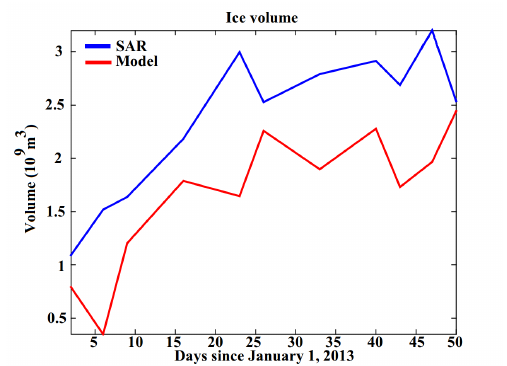
Figure 21. Sea ice volume calculated from the RADARSAT-2 SAR SIC and SIT estimates (blue) and from the HIGHTSI ice model (red). For the ice model-based ice volume, the SIC was produced from AMSR2 bootstrap algorithm. The ice volume is computed only over the common area of all the SAR